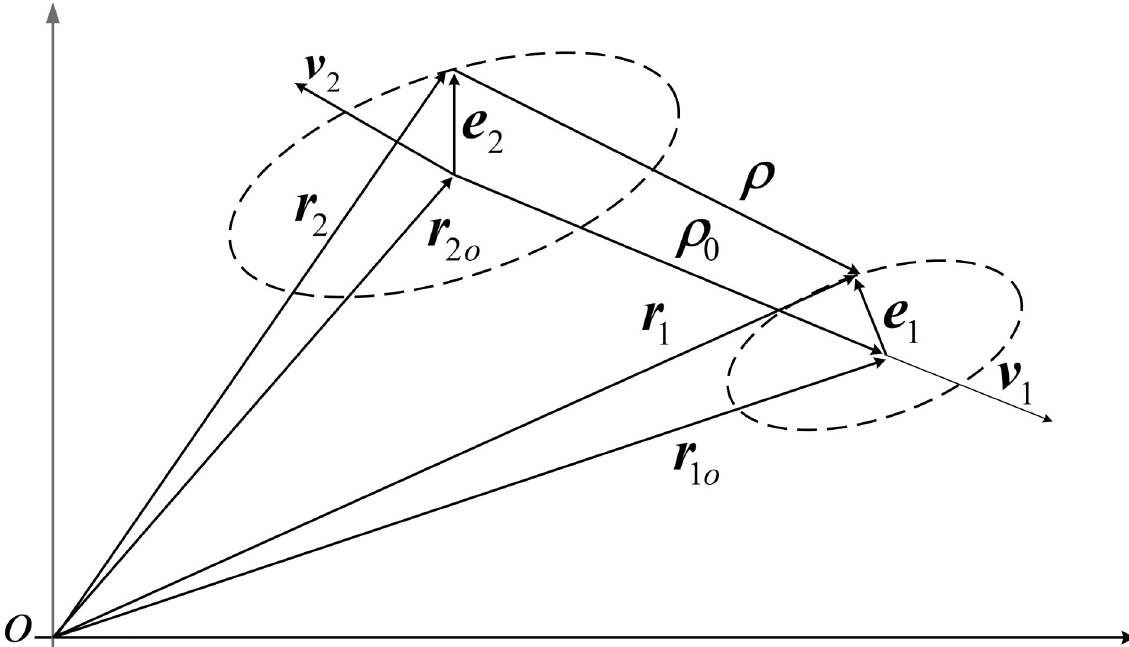
Fig 4. Geometrical relationship of position and velocity at